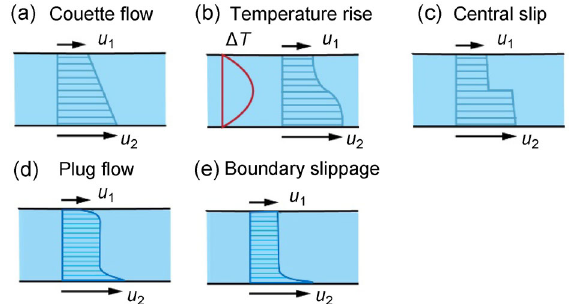
Fig. 1 Types of through-film speed